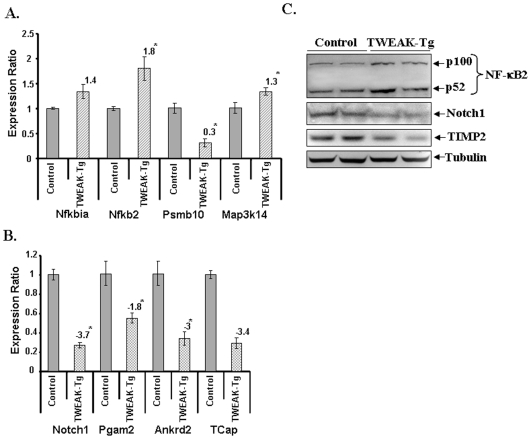
Differential expression of genes in skeletal muscle of TWEAK-Tg mice.Gastrocnemius muscle of 6 months old TWEAK-Tg mice and littermate control mice were used for total RNA isolation and QRT-PCR analysis. The relative expression values from the QRT-PCR analysis were plotted for each gene are mean ± SD (n = 3). The numbers above the bar represents the fold changes in TWEAK-Tg against littermate control mice, and ‘*’ represents the statistical significance (p-value ≤0.01). A) The levels of Nfkbia, Nfkb2, and Map3k14 were increased whereas the level of Psmb10 was found to be reduced in TWEAK-Tg mice compared to littermate control mice (n = 3 in each group). B). QRT-PCR analysis showed that the levels of Notch1, Pgam2, Ankrd1, and TCap were reduced in TWEAK-Tg mice compared to control mice (n = 3 in each group). C). Western blot analysis of NF-κB2, Notch1 and TIMP2 protein expression profiles in TWEAK-Tg compared to control mice. The gel pictures presented here from two independent experiments (n = 4) showed that protein levels of Notch1, and TIMP-2 were significantly reduced whereas NF-κB2 protein levels were increased in gastrocnemius muscle of TWEAK-Tg compared to littermate control.